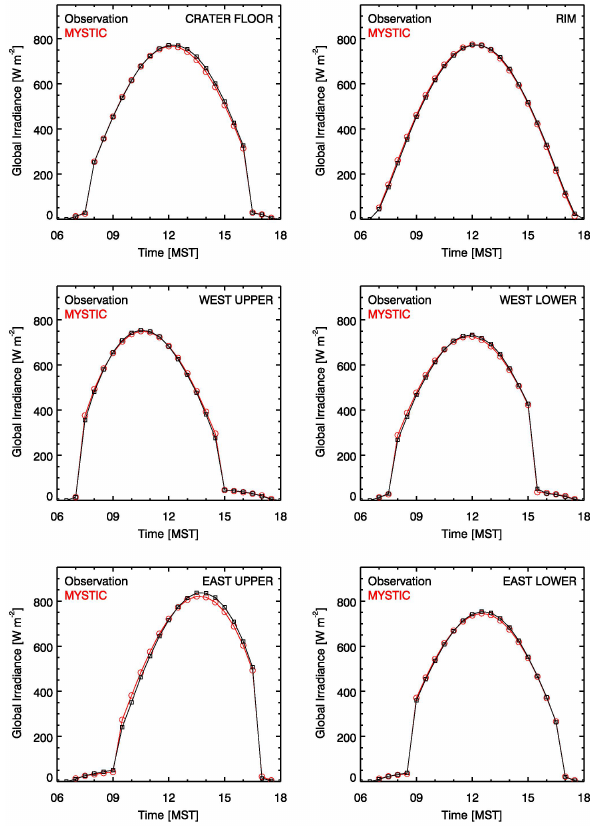
Fig. 5. Observed (black) and modeled (red) shortwave direct ir- radiance (left) and diffuse irradiance (right) at the crater floor for 21 October 2006.